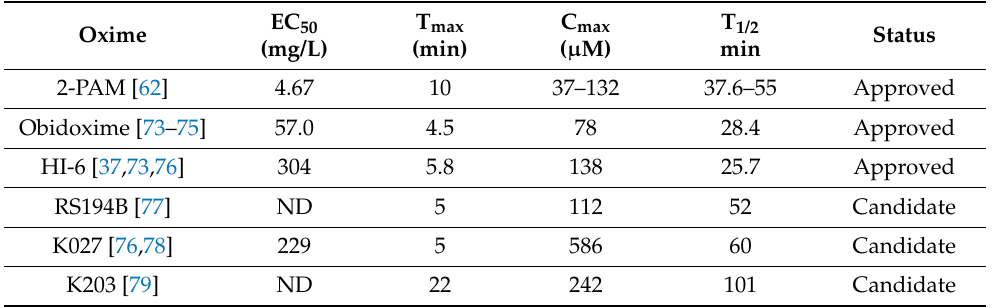
Table 1. Various pharmacokinetic parameters of common oxime based antidotes. (t 1/2 : half-life excretion time; C max : maximum concentration in blood plasma; and T max : time to reach C max ). (C max and T max listed for injected concentrations not exceeding 50